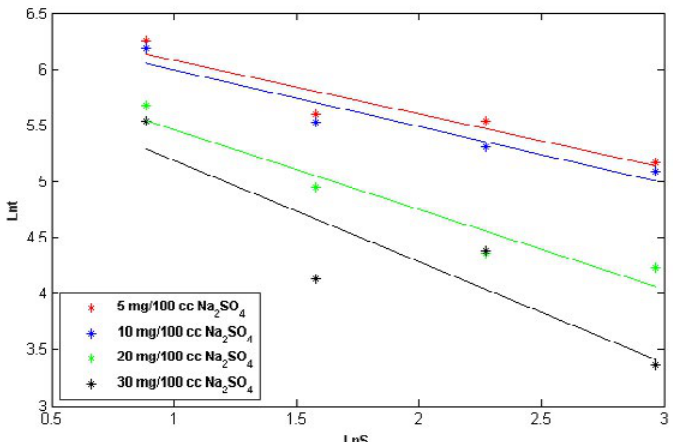
Fig. 5. BaSO crystallization in different Na 4